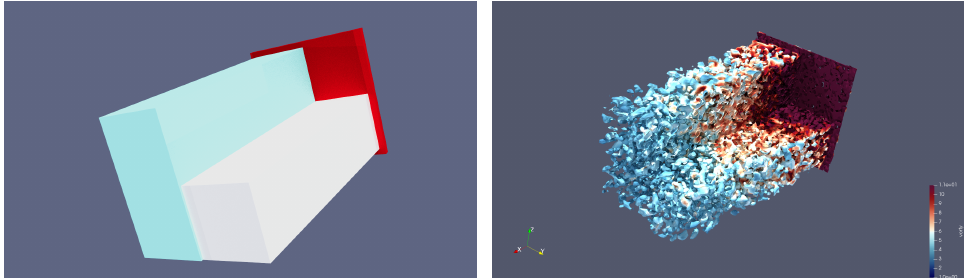
Figure 9. Iso-surfaces of the λ 2 quantity and colormaps of the vorticity magnitude on the generation block and on a portion of the control block ( right ). Sketch of the considered control block portion ( left